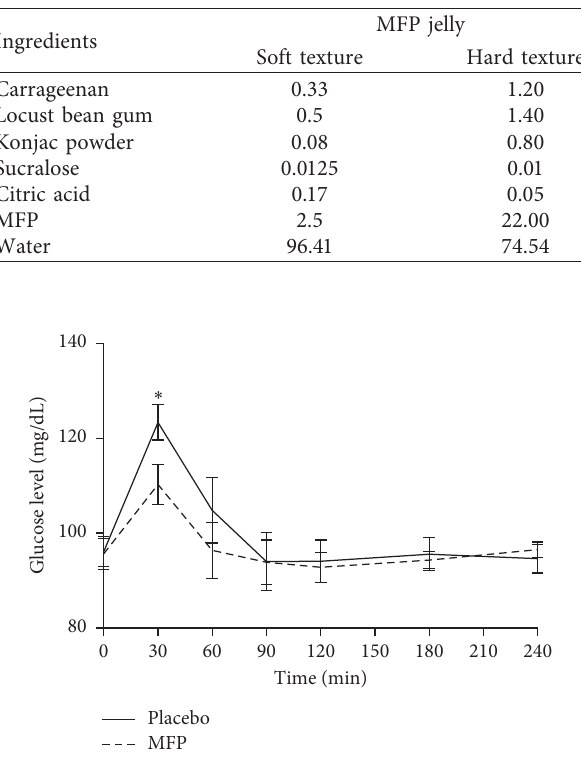
Figure 1: Blood glucose response after consuming two jelly samples (placebo and MFP jelly), data expressed as mean ± SE. The sign “ ∗ ” expressed as statistically significant ( p value <